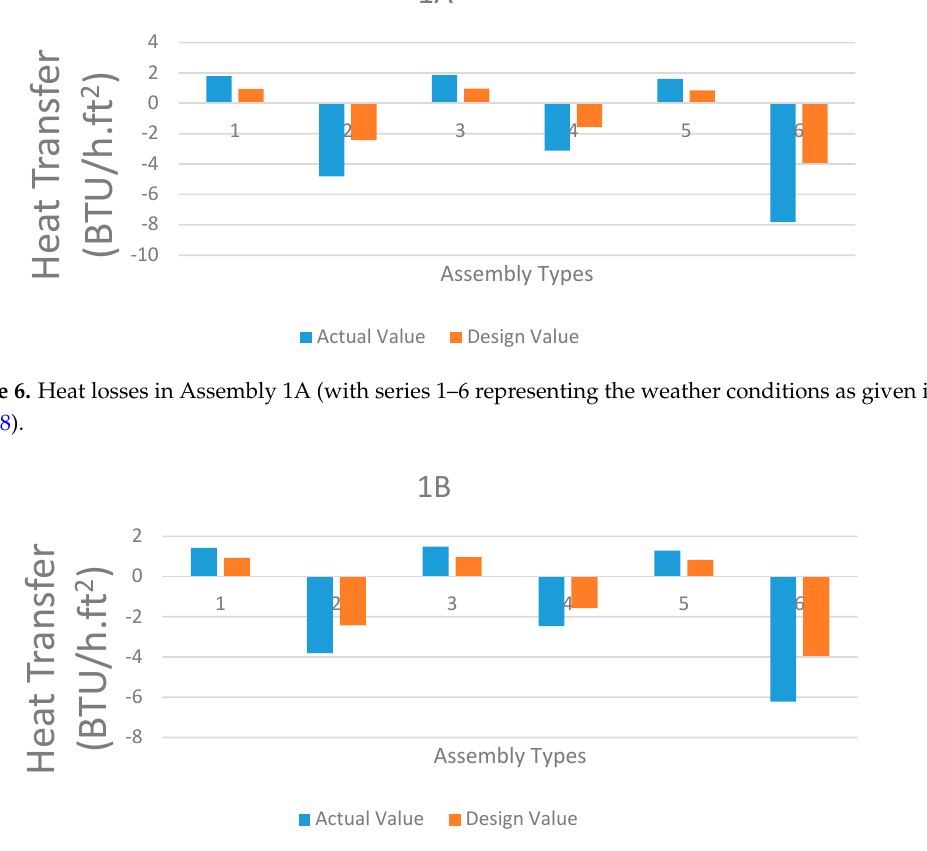
Figure 7. Heat losses in Assembly 1B (with series 1–6 representing the weather conditions as given in Table 8).